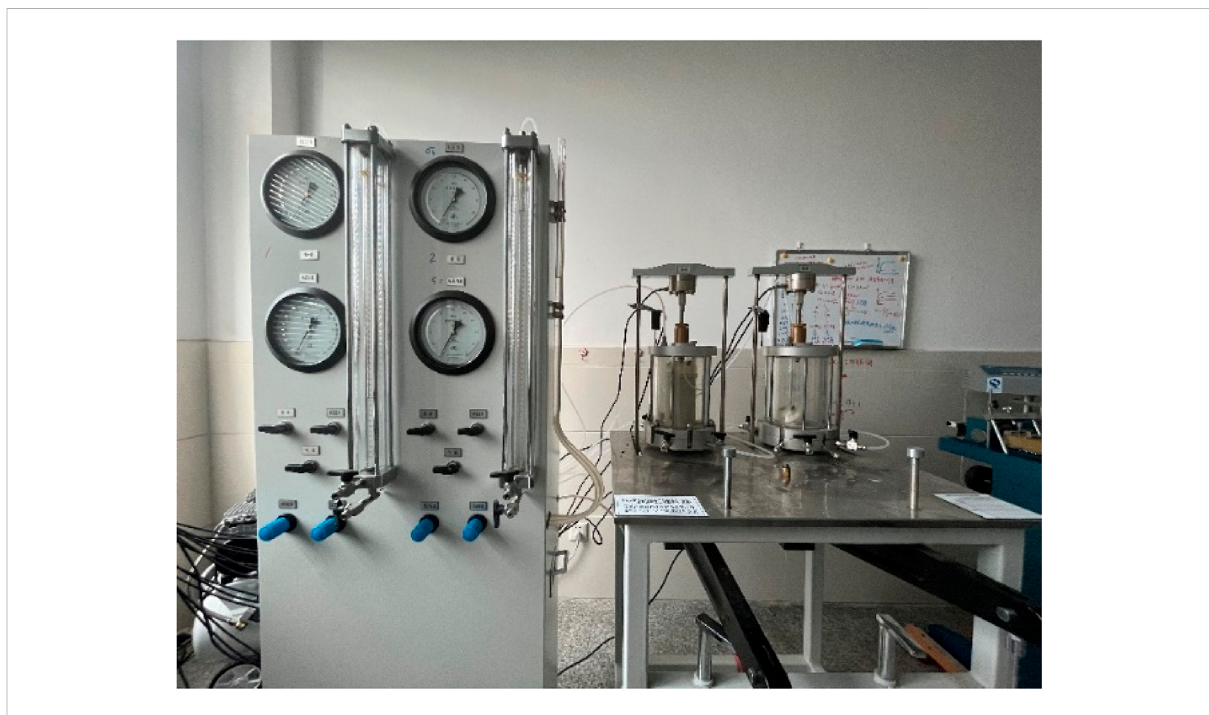
FIGURE 2 Unsaturated soil triaxial creep test